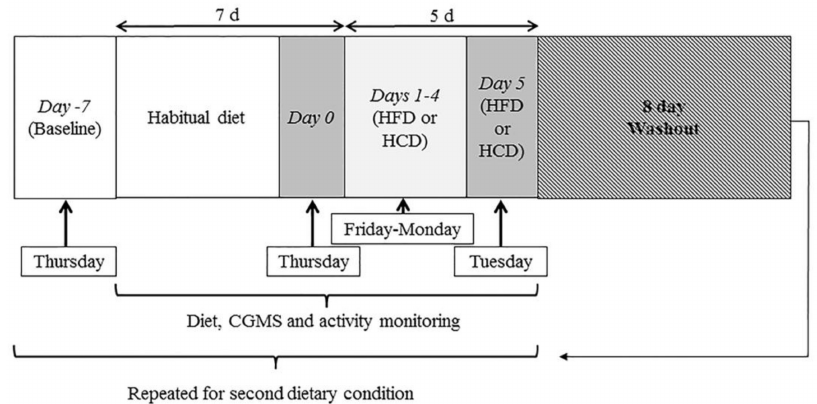
Figure 1. Study design schematic. Participants ( n = 8) visited the laboratory on 10 occasions. Two trial conditions (high-fat diet (HFD; 67% total energy intake (TEI) fat, 15% TEI carbohydrate, and 18% TEI protein) and high-carbohydrate diet (HCD; 67% TEI carbohydrate, 15% TEI fat, and 18% TEI protein) were completed in a randomised order separated by an 8-d washout period. Dietary assessment, continuous glucose monitoring system (CGMS), and activity monitors were all worn and assessed throughout the 7-d habitual and 5-d experimental periods (total 12 d) for each trial condition. Day − 7 (Baseline habitual period; Thursday): Participants arrived fasted (>10 h) at 0630 h for baseline measures before commencing their 7-d ‘habitual’ baseline recording period. REE was assessed for the final 15 min of 25 min using a calibrated TrueOne metabolic cart (TrueOneRMR, Parvo Medic, Sandy, UT, USA) to measure oxygen consumption (VO 2 ), carbon dioxide (VCO 2 ), and energy expenditure (kJ/d), with a mean coefficient of variation of 4%. Body composition was assessed via dual-energy x-ray absorptiometry (DXA; GE Lunar iDXA Pro, enCORE software Version 16, General Electric, Boston, MA, USA) to obtain total mass (kg), fat mass (FM; kg), fat-free mass (FFM; kg), bone mineral content (BMC; kg) and estimations of visceral adipose tissue (kg)